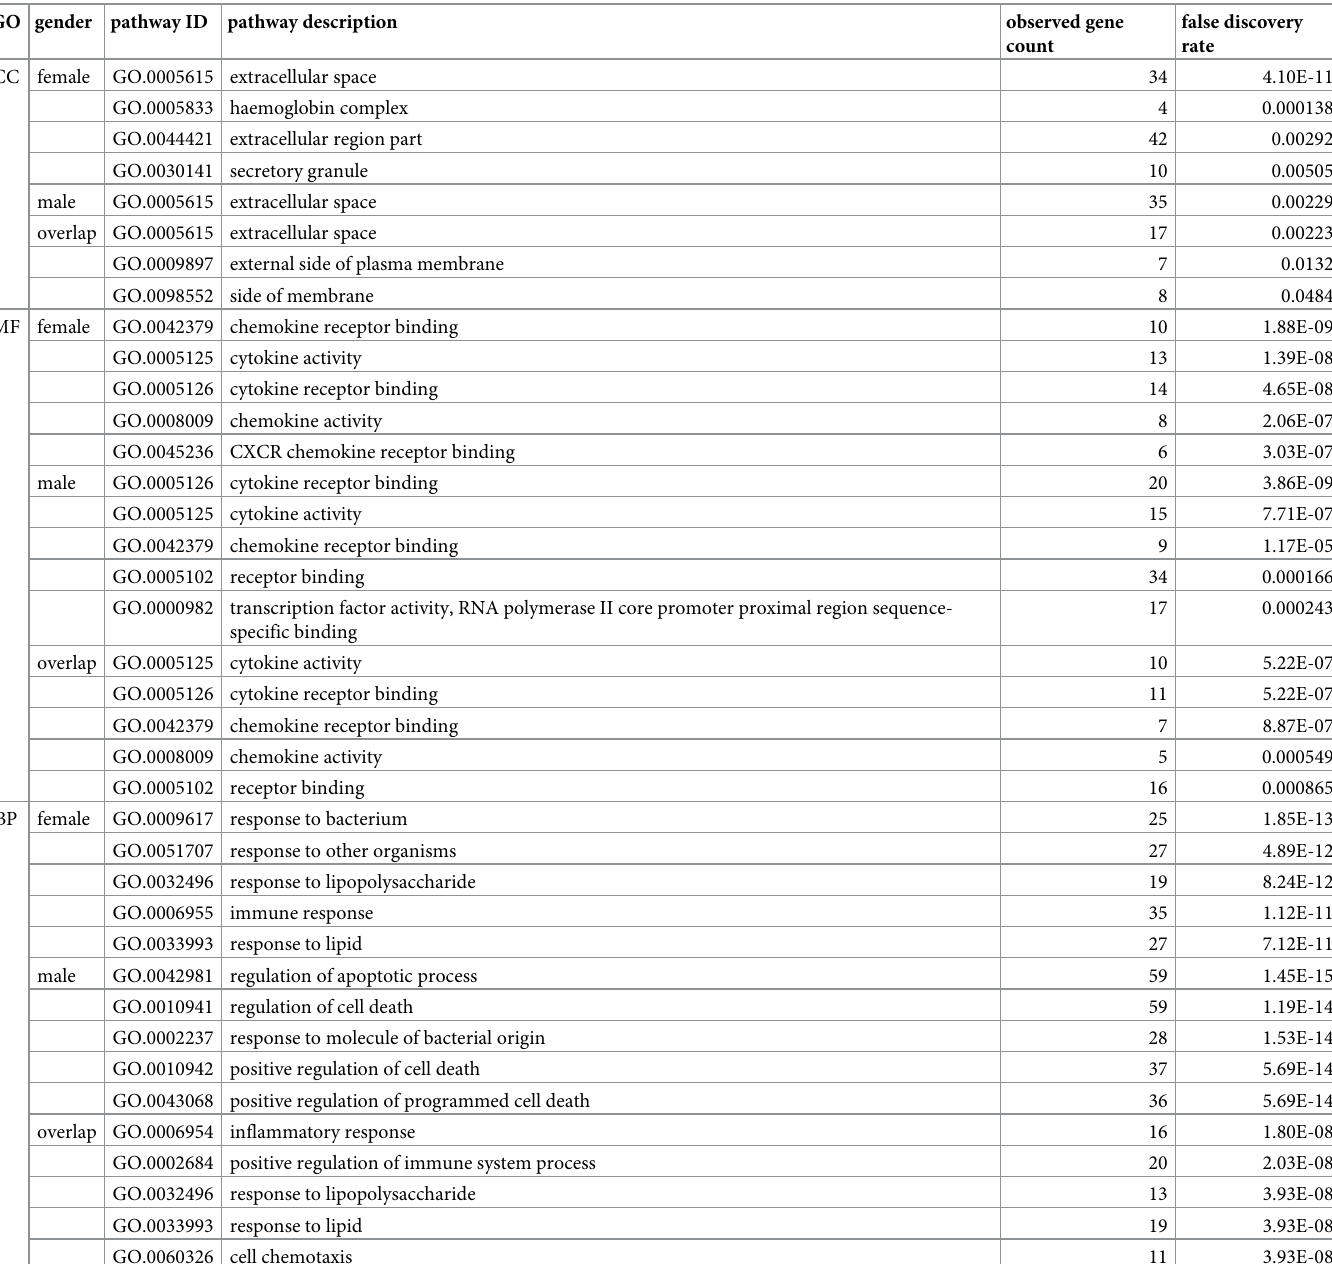
Table 1. GO enrichment analysis in